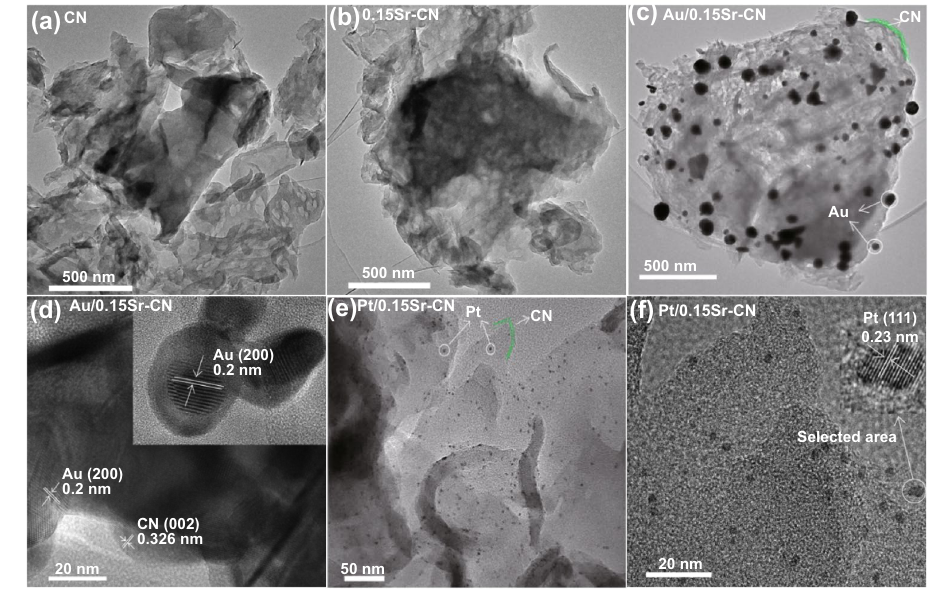
Fig. 2 TEM micrographs of a CN, b 0.15Sr-CN and c of Au/0.15Sr-CN. HRTEM micrograph of d Au/0.15Sr-CN sample. e TEM micrograph and f HRTEM micrograph of